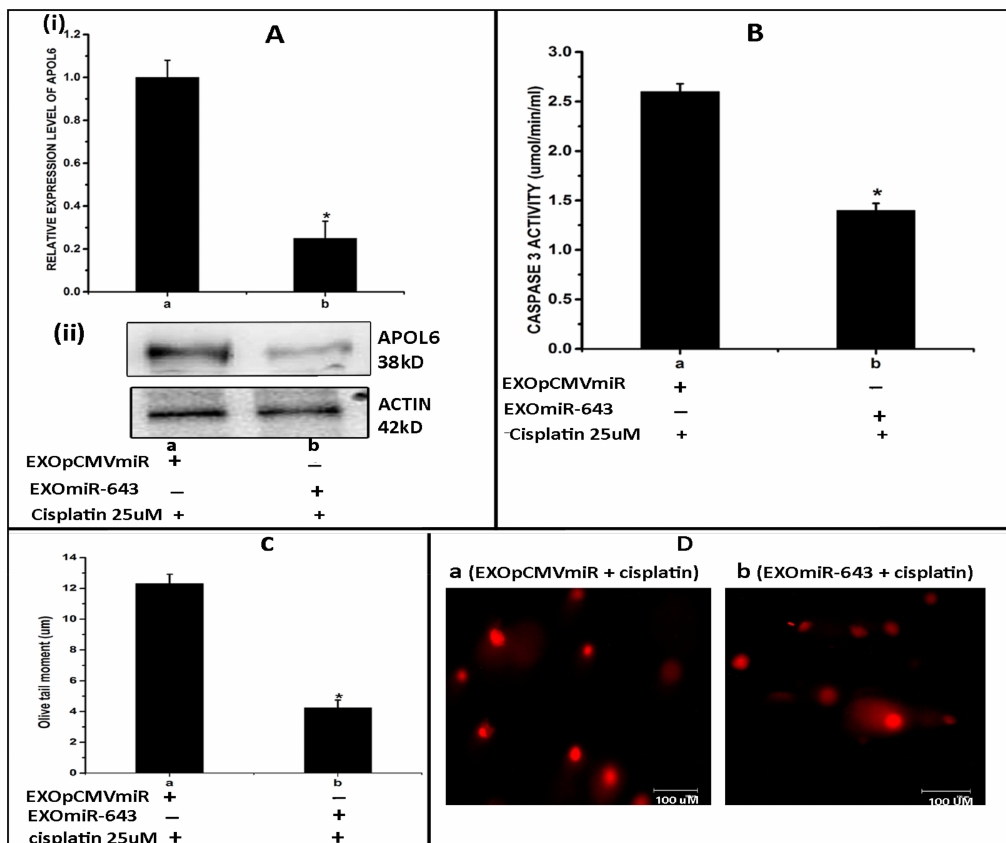
Figure 8. Exosomes enriched with miR-643 reduces APOL6 levels, decreases caspase activity, and promotes cell survival in recipient cells. Hela cells were treated with miR-643 enriched exosomes 24 h post treatment, RNA and protein was isolated to determine APOL6 mRNA and protein levels by RT-PCR and Western blot analysis, respectively. ( A ) Levels of ( i ) APOL6 mRNA analysed by RT-PCR ( ii ) APOL6 protein analysed by Western blot. ( B ) Caspase 3 activity in Hela cells treated with EXO miR-643 . ( C ) Representative microphotographs of comets obtained from comet assay in Hela cells treated with EXO miR-643 . ( D ) Olive tail moment analysed by comet assay in Hela cells treated with EXO miR-643 using open comet software. In ( A – D ), a—Hela cells treated with EXO (pCMVmiR) and cisplatin and b—Hela cells treated with EXO (miR-643) + cisplatin. The mean values of two different experiments ± SEM each performed in triplicate are reported in the graph, p < 0.05. * indicates statistical significance when compared to